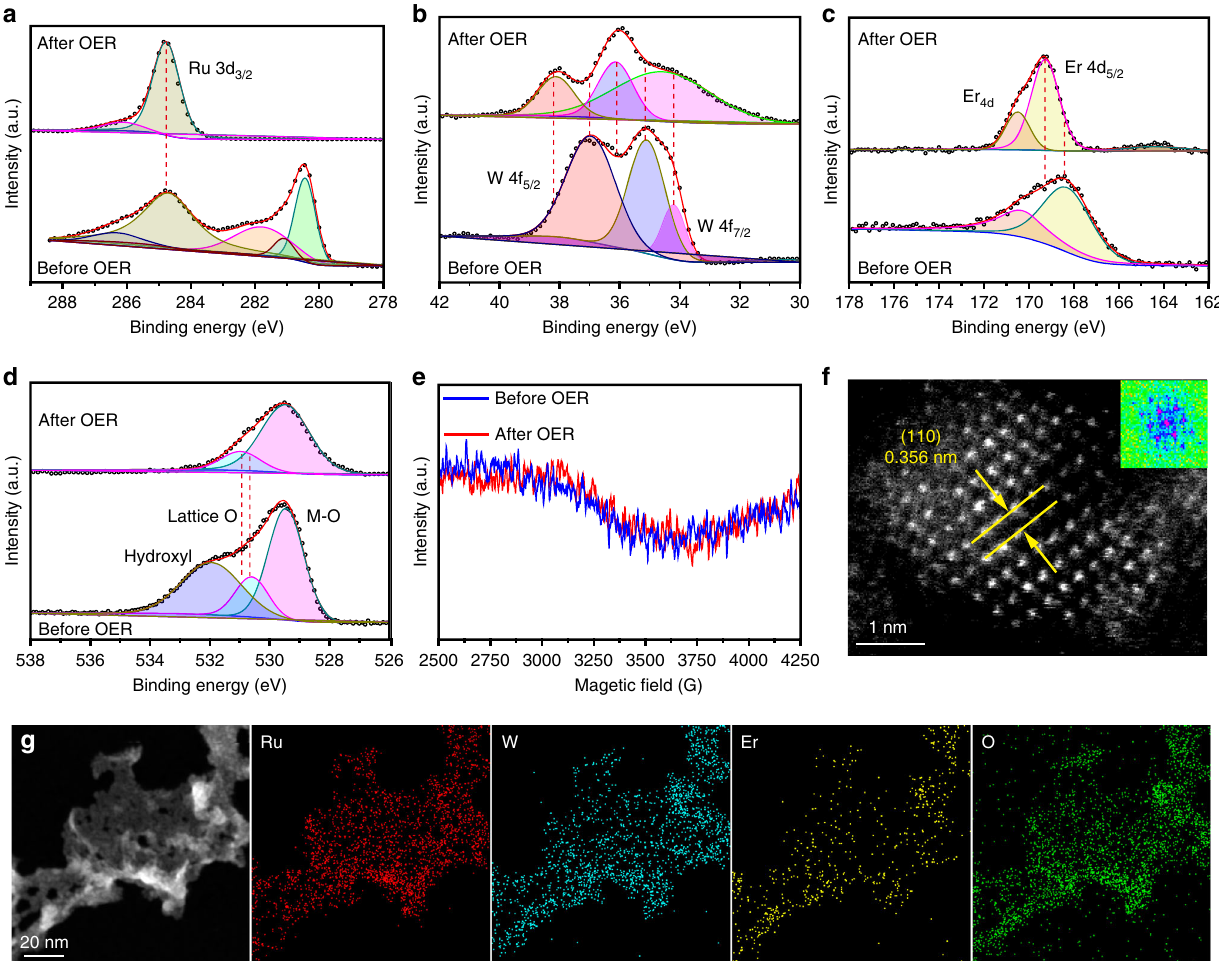
Fig. 8 Chemical recognition and characterization for W 0.2 Er 0.1 Ru 0.7 O 2 − δ after 500 h stability. a Ru 3 d spectra, b W 4 f spectra, c Er 4 d spectra, d O 1 s spectra for W 0.2 Er 0.1 Ru 0.7 O 2 − δ before and after 500 h stability. e ESR spectra for W 0.2 Er 0.1 Ru 0.7 O 2 − δ before and after 500 h stability. f HR-TEM image, g Elemental mapping for W 0.2 Er 0.1 Ru 0.7 O 2 − δ after acidic OER